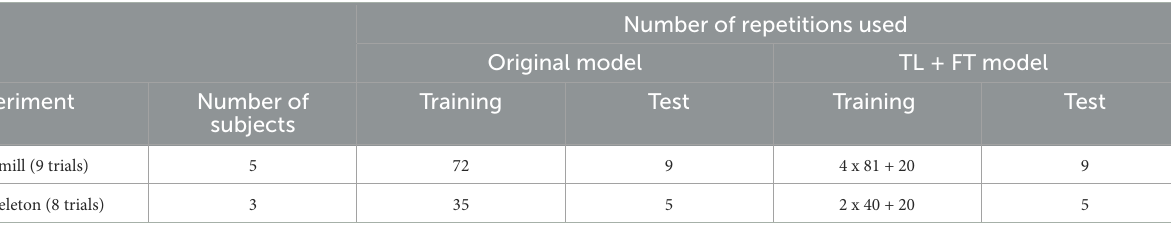
TABLE 3 Number of repetitions used for the comparison between the original model (NN1 + NN2) and the updated TL + FT model in the pseudo-online analysis.